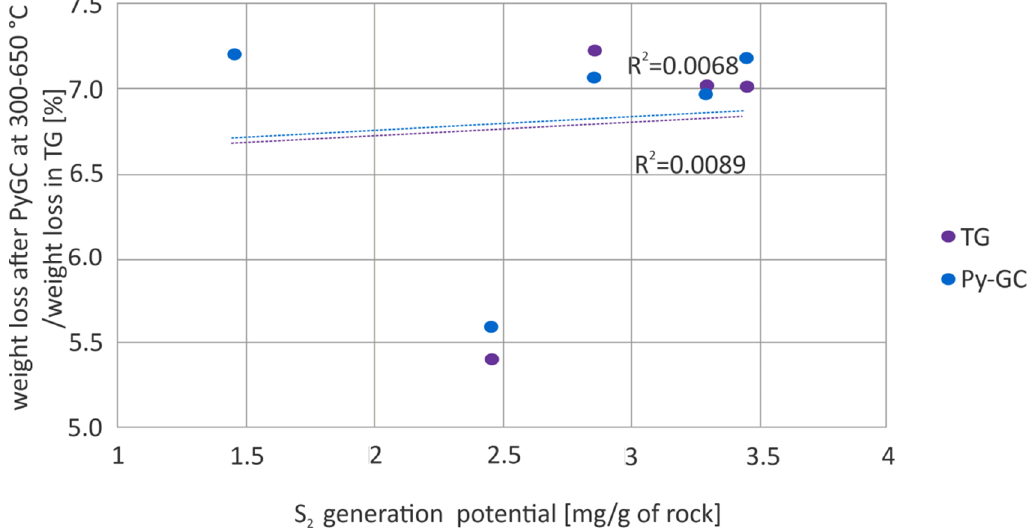
Figure 11. Dependence of weight loss on S 2 generation potential for rock samples from the Istebna Beds during Py/GC and TG/DTG pyrolysis at temperatures of 300 to 650 °C.